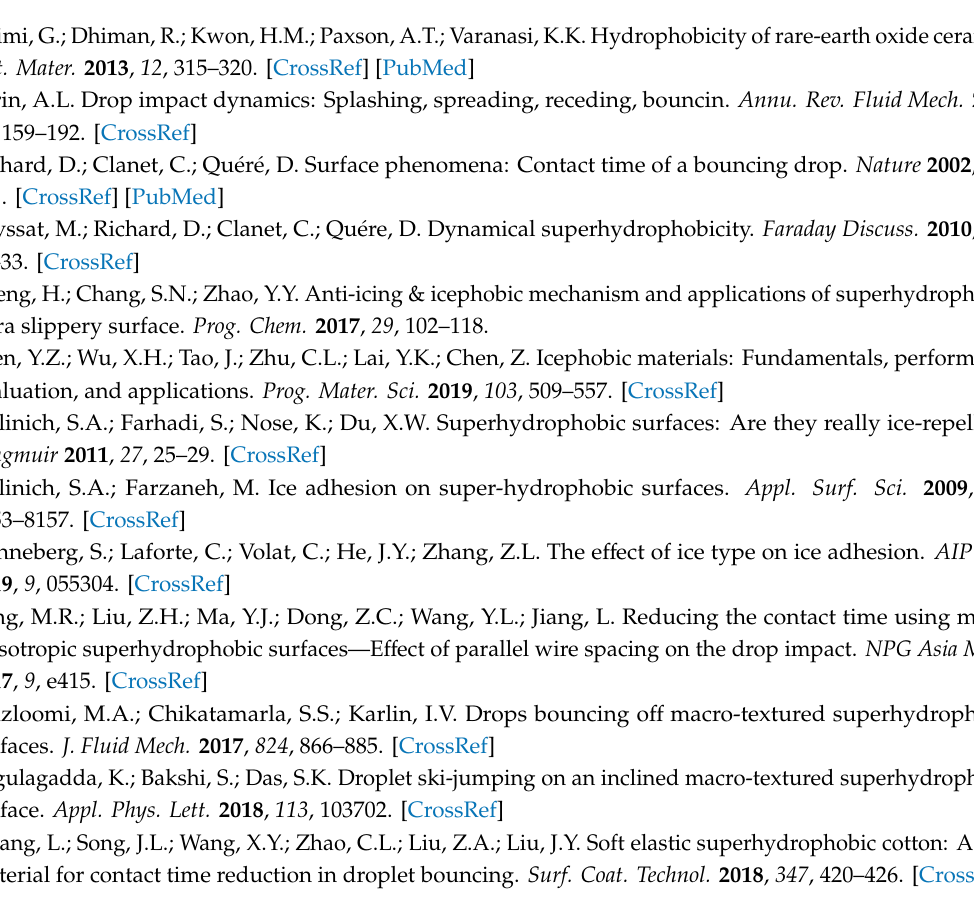
Figure S1: Bounce diagram of water droplet on a superhydrophobic surface, Figure S2: Schematic diagram of three-level structured plane